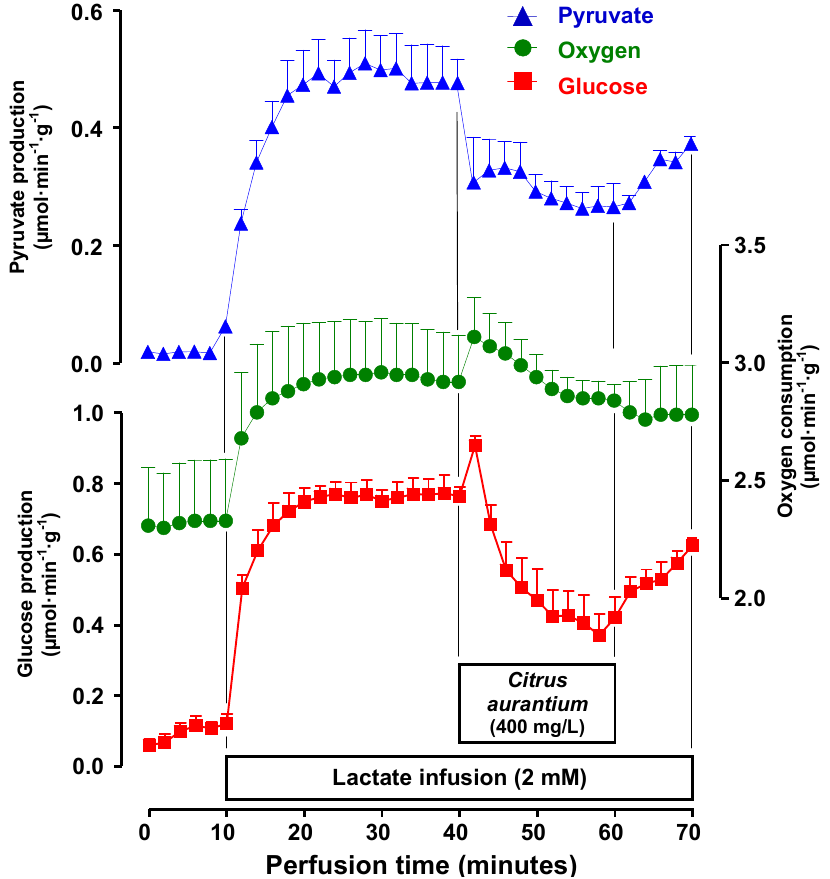
Figure 5. Time courses of the effects of the C. aurantium extract on gluconeogenesis from lactate and related parameters in perfused livers from fasted rats. Livers from fasted rats were perfused as described in the Experimental Section. Lactate (2 mM) and Citrus aurantium were infused as indicated by the horizontal bars. Each datum point represents the means of three liver perfusion experiments. Bars are standard errors of the